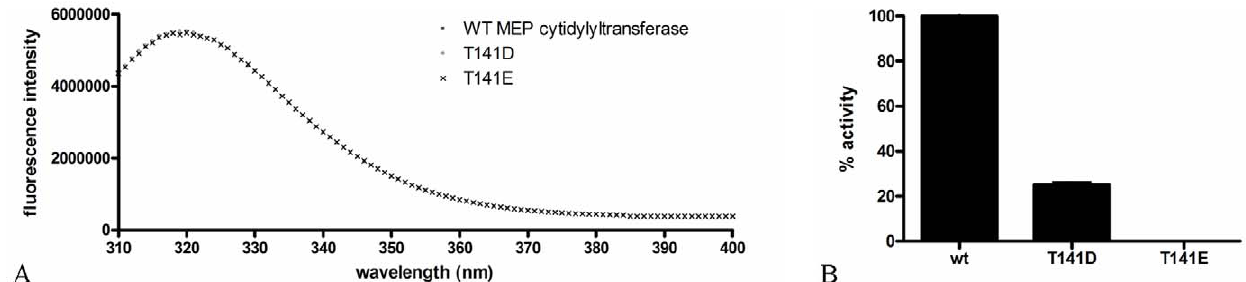
Figure 7. Regulation of F.tularensis MEP cytidylyltransferase. A) Intrinsic fluorescence spectra of MEP cytidylyltransferase and two mutant derivatives. Wildtype and mutant (T141D and T141E) proteins were adjusted to 5 m M in 0.1 M Tris pH 7.5, 1 mM NaCl and analyzed using an excitation wavelength of 290 nm. The emission spectra was measured from 310 to 400 nm. The Em l max of all three proteins was detected at 320 nm. Identical spectra indicate little structural change in the protein globular fold accompanies the introduction of either Asp or Glu. B) The relative activity of wildtype MEP cytidylyltransferase and the T141D and T141E mutants. Assays were performed in duplicate with 200 m M MEP and 200 m M